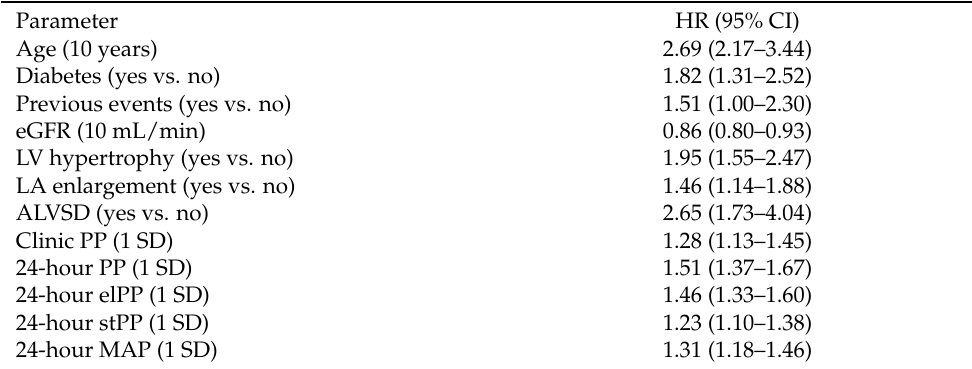
Table 4. Results of the univariate